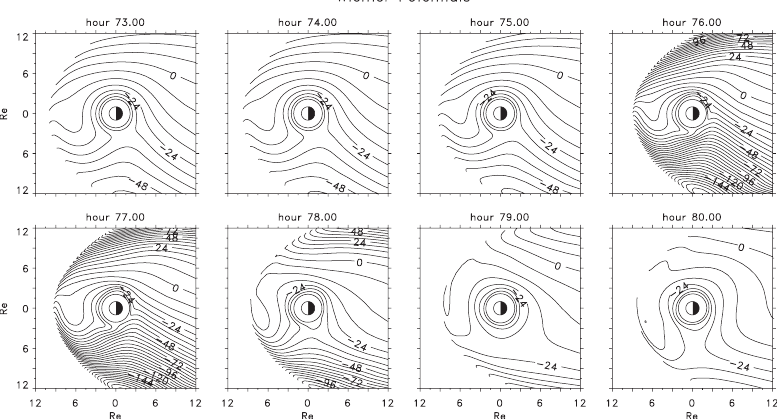
Fig. 3. Electric potential isocontour plots like Fig. 2, except for the Weimer-96 electric field model. Note that corotation is included in the potential